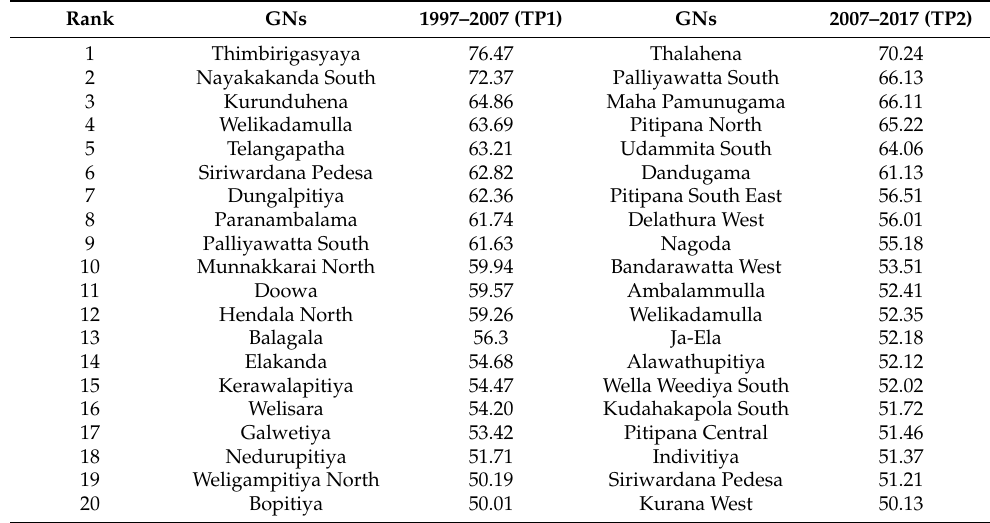
Table A2. Top 20 GNs in the MMNL in terms of density of wetland loss due to urbanization (settlement expansion) (WLD) (%) (see Equations (3) and